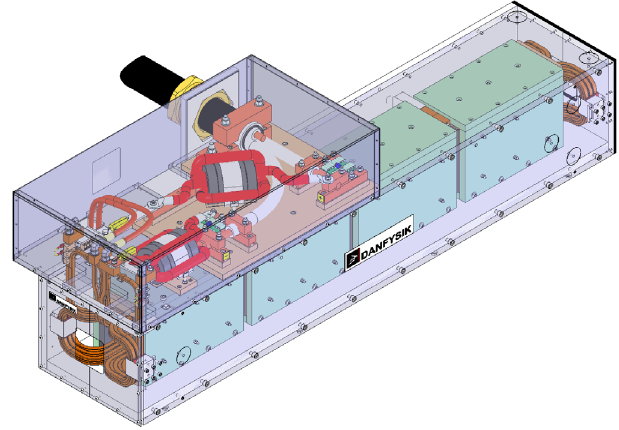
FIG. 9. 3D engineering drawing of the UCN kicker magnet and connection box. The overall length of the magnet is ∼ 1 . 71